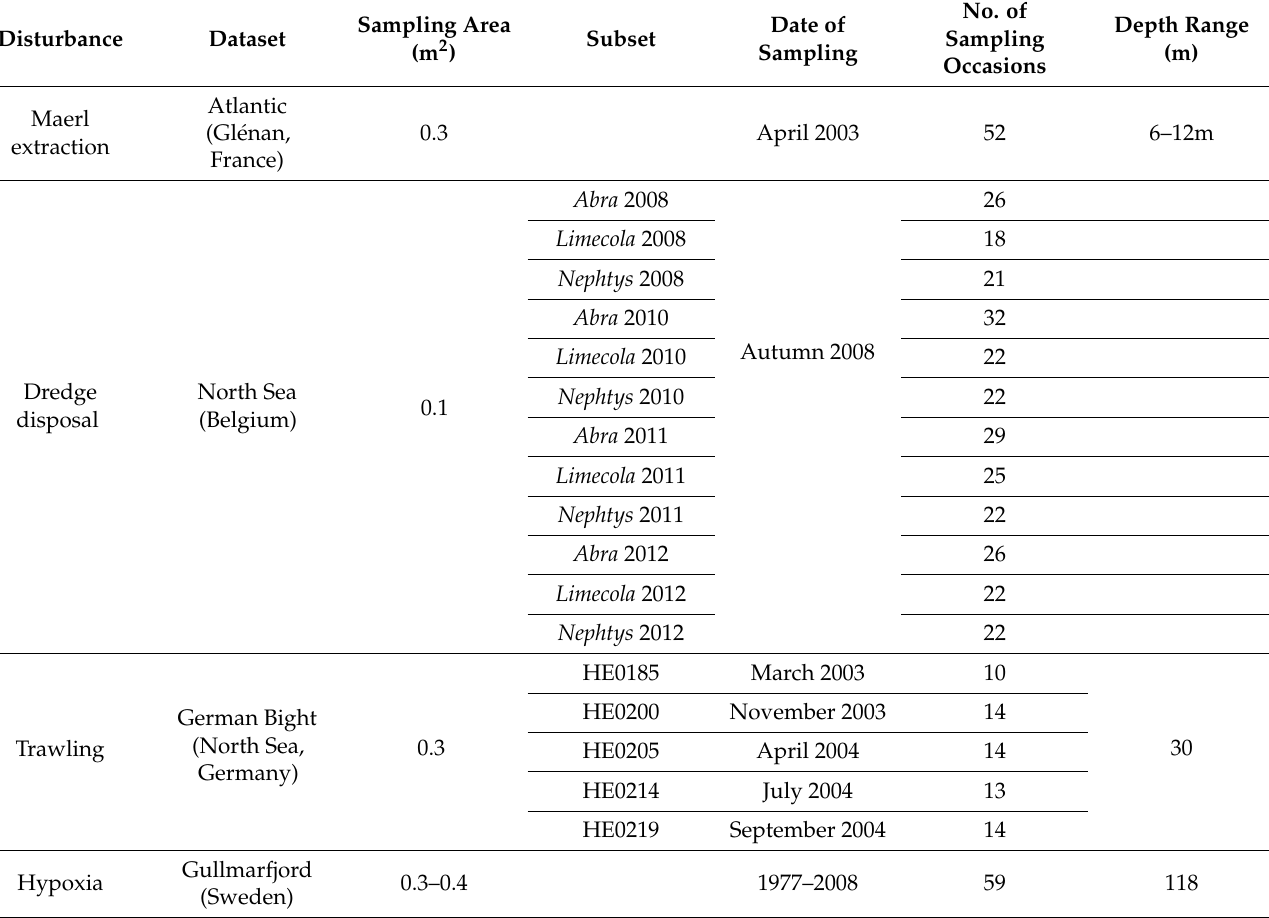
Table 1. Main characteristics of the datasets, including disturbance type, dataset region, sampling effort (m 2 ) per sampling occasion, subsets, sampling dates, number of sampling occasions, and water depth